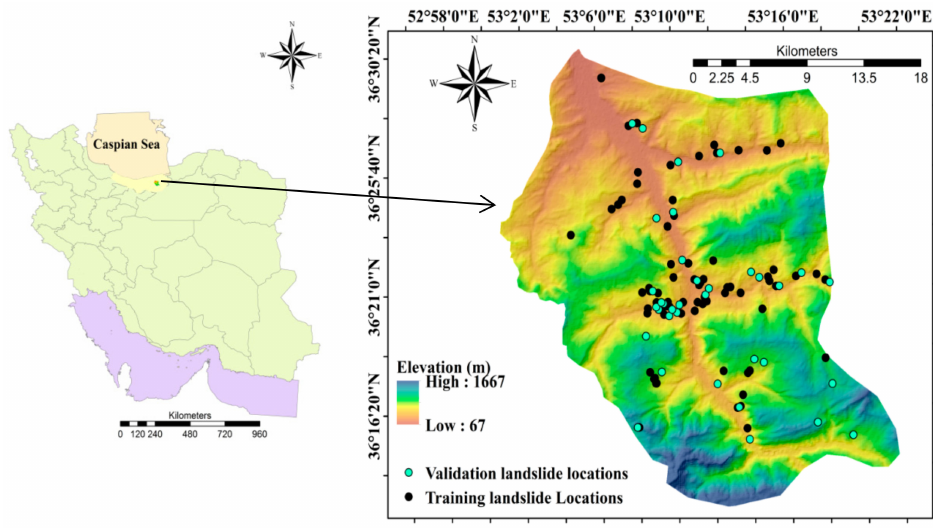
Figure 1. Landslide location map of the study